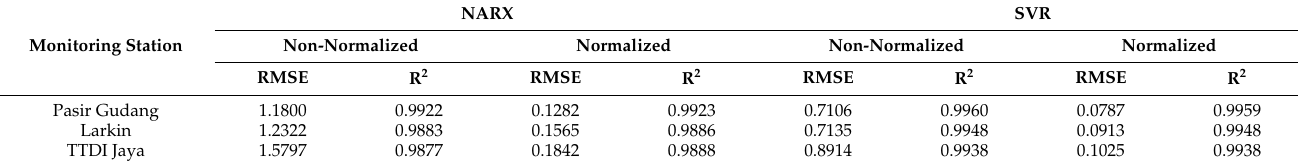
Table 2. The RMSE and R 2 values using non-normalized and normalized data.